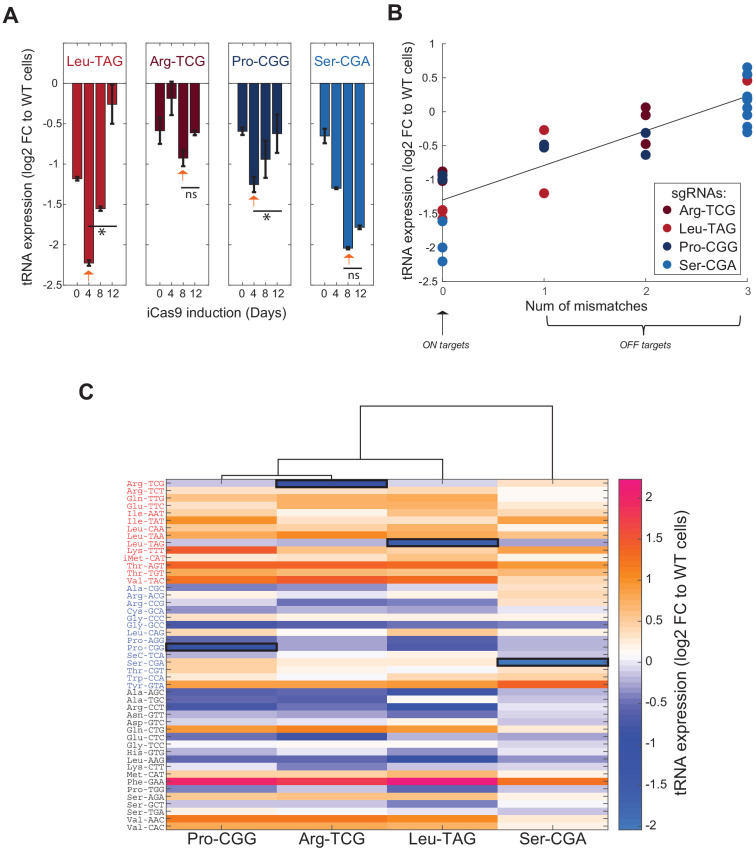
Genomic editing of proliferation-demanded tRNAs exerts a negative selection and a global change in the cellular tRNA pool in HeLa cells.(A) Bar plots describing the tRNA expression dynamics along the iCas9 induction for each CRISPR-targeted tRNA. The y-axis depicts the fold-change (log2) in the tRNA expression of the CRISPR-targeted tRNA in the treated cells relative to WT cells, summed over all gene members of the CRISPR-targeted tRNA family. Each bar represents a time point during the iCas9 induction (n = 2) and the error bars depicts the standard errors. The orange arrows point on the maximized expression reduction of the CRISPR-targeted tRNA during the iCas9 induction. The two left plots describe the proliferation edited tRNA families and the two left plots describe the differentiation edited tRNA families. * indicates p<0.05 and ns indicates non-significant p-value of two-sample T-tests comparing between the sample with the highest expression reduction and the last time point. (B) A scatter plot of the correlation between the number of mismatches of the CRISPR-targeted tRNAs (both ON-target and OFF-targets) relative to the corresponding sgRNA sequence and their change in expression in CRISPR-targeted HeLa cells (Pearson correlation, r = 0.87, p<10−4). Each dot represents a tRNA gene family with a potential to be targeted by a sgRNA (with 0–3 mismatches), while the sgRNA is indicated by the color. The ON-targets have 0 mismatch, while OFF-targets consists between 1–3 mismatches. The y-axis depicts the fold-change (log2) in the tRNA expression of the potential targets in the CRISPR-treated HeLa cells relative to WT HeLa cells, averaged over two biological repeats. (C) A heat map representing the differential expression of the cellular tRNA pool in CRISPR-targeted tRNA cells. Each column represents a cell population with CRISPR-targeted tRNA family, and each row represents a tRNA isodecoder, grouped by their type (proliferation-red/differentiation-blue/other-black). The color code depicts the fold-change (log2) in tRNA expression in the CRISPR-targeted tRNA sample at day8 of the iCas9 induction relative to the WT sample at the same day, averaged over two biological repeats. The expression level of the ON-target tRNA in each sample is marked in black square. The dendrogram represents the hierarchical clustering of the different CRISPR-targeted tRNA samples based on changes in tRNA expression profile.
Figure 2—source data 1.Primer sequences for genomic tRNA sequencing.